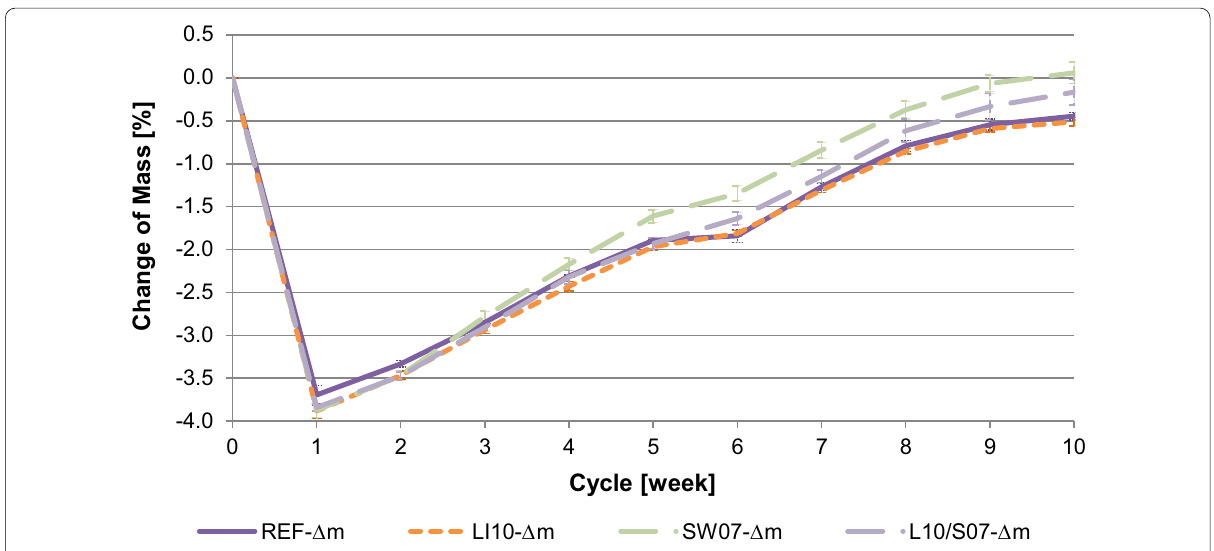
Fig. 12 Comparison of mass changes of cement-bonded particleboards exposed to wet–frost–dry cycling according to EN 321